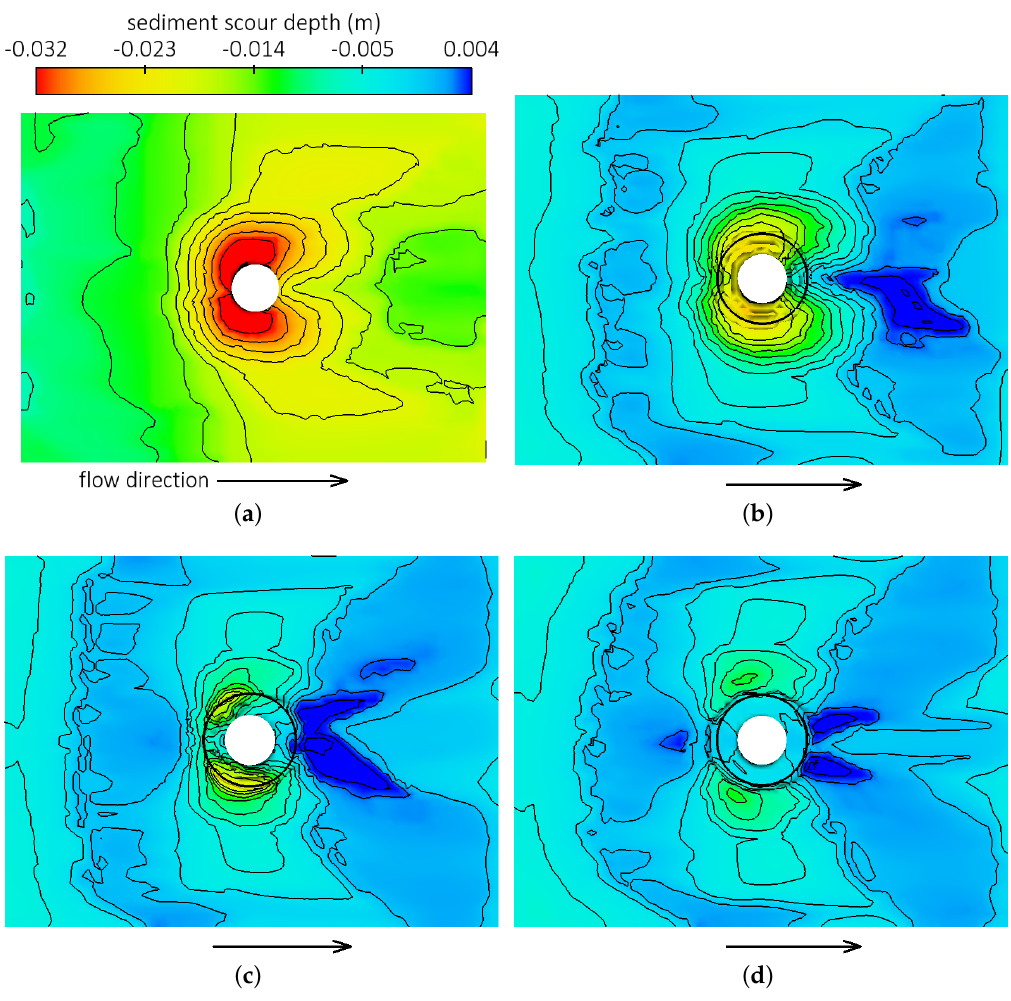
Figure 8. Contours of scour depth: ( a ) no hooked-collar; ( b ) single hooked-collar at 0.25 b ; ( c ) single hooked-collar at bed level; and ( d ) double collar at the bed and buried − 0.25 b